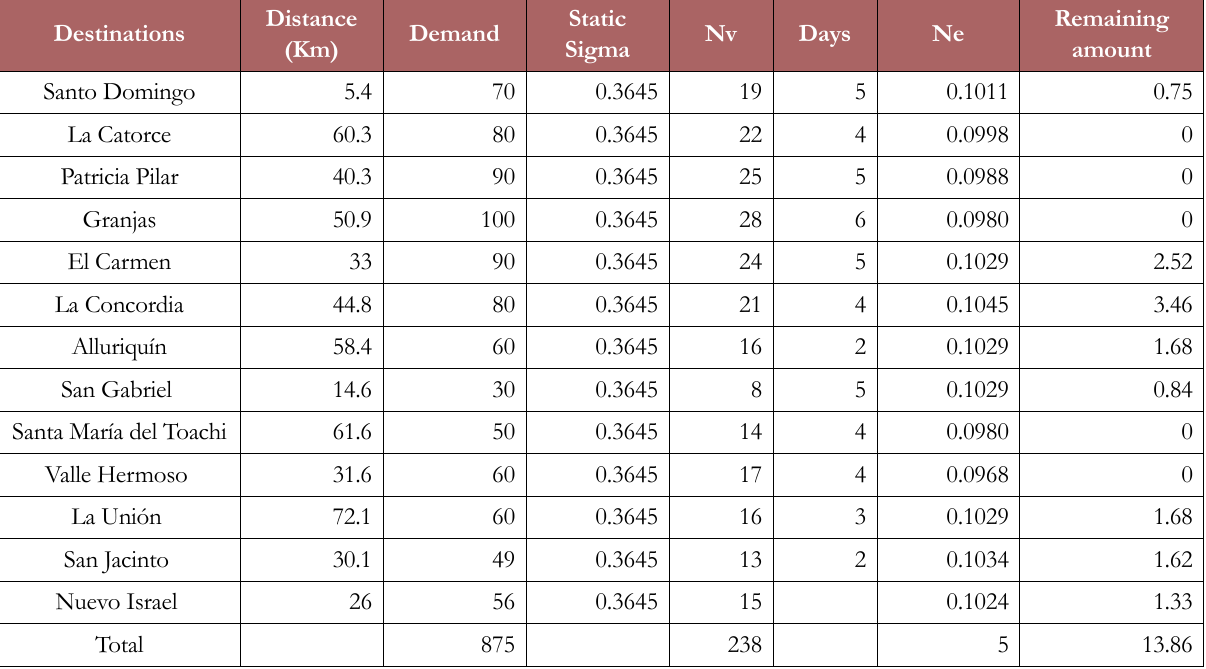
Table 11. Load Capacity per